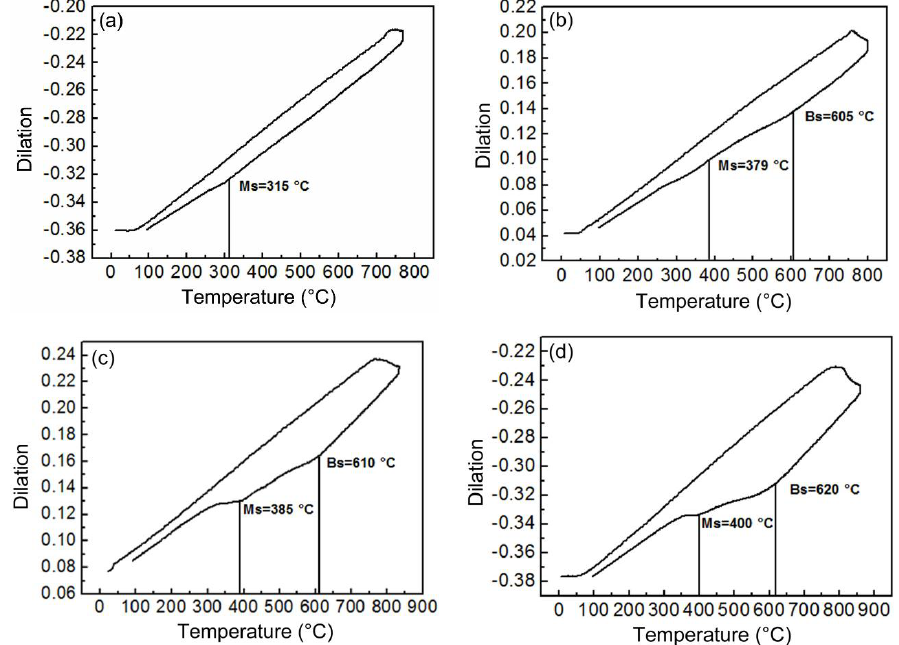
Figure 5. Dilatometric curves for the simulated IC HAZ specimens with varying peak temperatures: ( a ) 770, ( b ) 800, ( c ) 830, and ( d ) 860 °C.